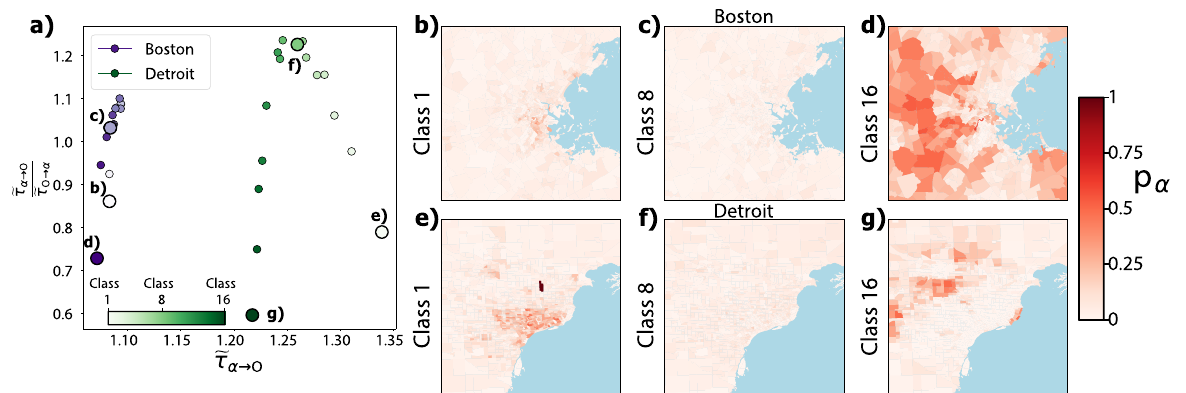
Fig. 8 Characterisation of residential segregation in Boston and Detroit through class mean fi rst passage times (CMFPT). a Position in the ( e τ α ! O ; e τ α ! O = e τ O ! α ) phase space of each of the income classes in Boston (shades of blue) and Detroit (shades of green). Here e τ α ! O stands for the average normalised CMFPT from a class α to the rest of classes and e τ O ! α from the rest of classes to a class α . b – d Distribution of the probability of fi nding a class α in each census tract of Boston, respectively for Class 1 ( b ), Class 8 ( c ) and class 16 ( d ). e – g Distribution of the probability of fi nding a given class α in each census tract of Detroit, again for Class 1 ( e ), Class 8 ( f ) and Class 16 ( g ). Class numbering goes from the most deprived (Class 1) to the wealthiest one (Class